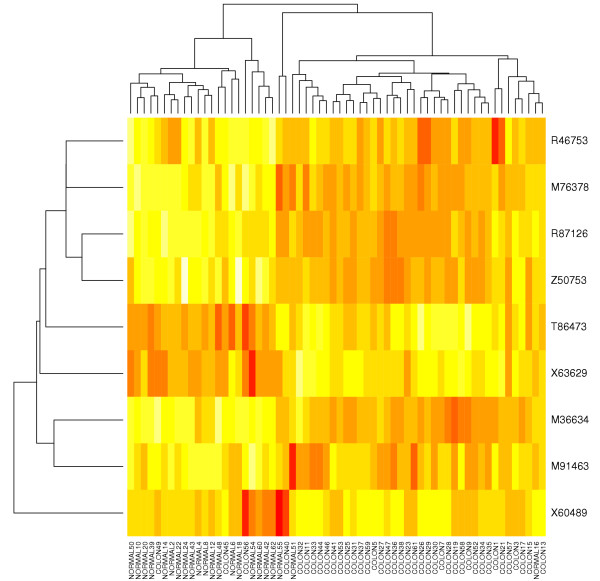
Clustering dendrogram of colon cancer data – Reduced Feature Set.